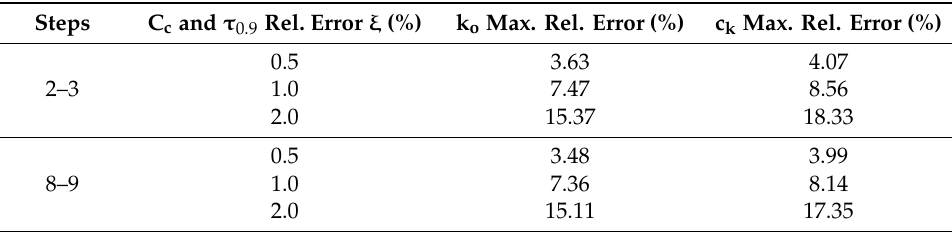
Table 14. Maximum errors of k o and c k as a function of ξ (high muscovite content soil).